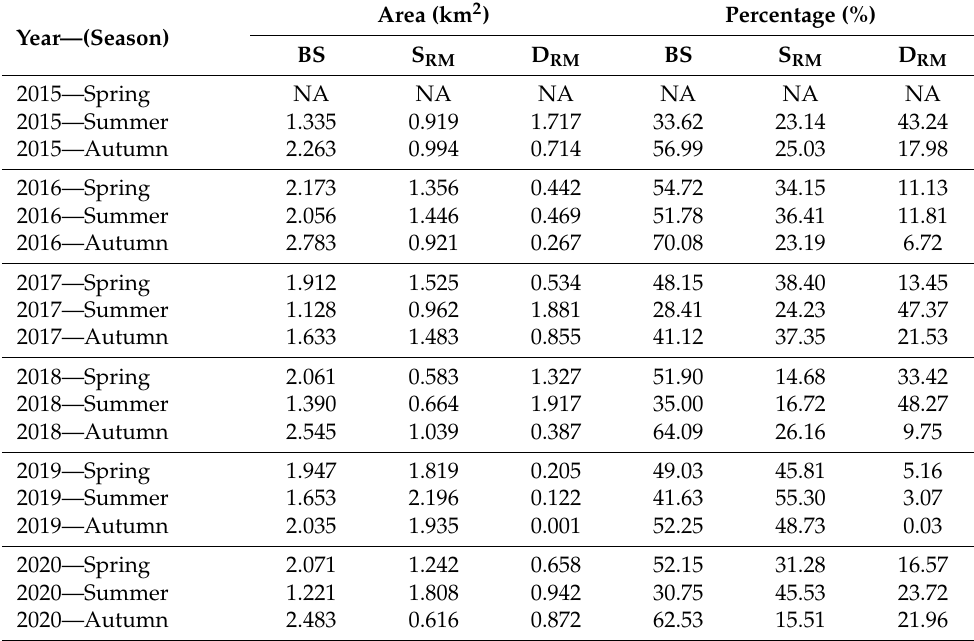
Table 2. Area (km 2 ) and percentage coverage of the three classes of bottom cover for each seasonal map (2015–2020): bare sediment (BS), sparse macrophytes (S RM ), and dense macrophytes (D RM